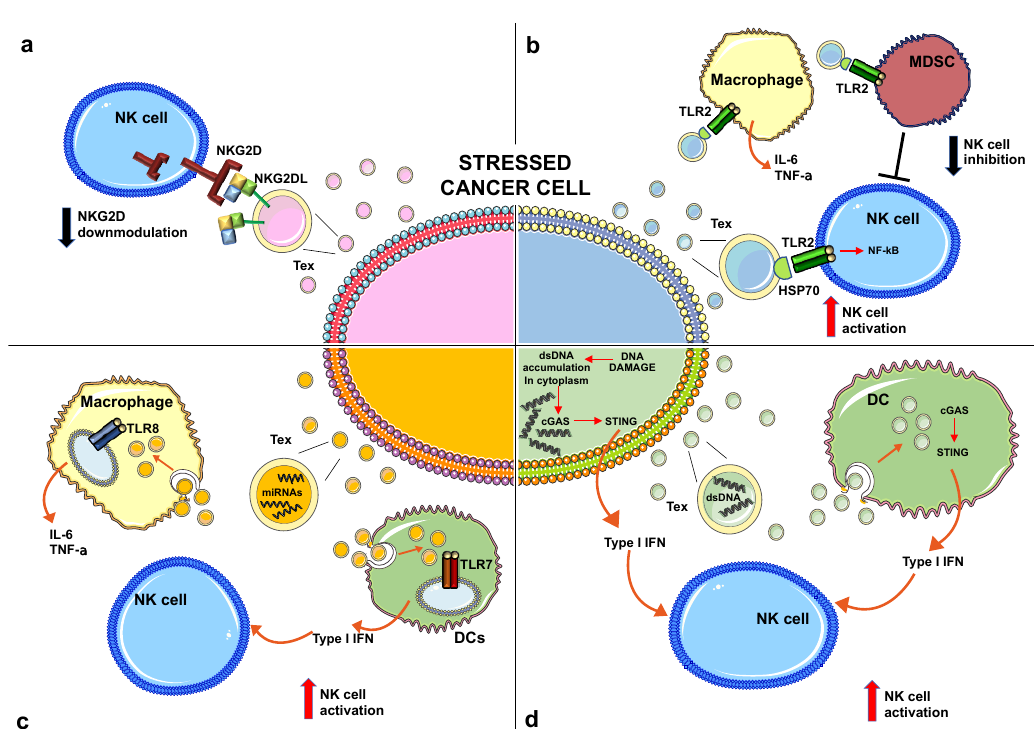
Figure 1. Effects of distinct molecules produced by stressed cancer cells on NK cell-mediated functions. ( a ) Exosomes expressing NKG2D ligands induce NKG2D downmodulation leading to an impairment of NKG2D-mediated cytotoxicity. ( b ) Exosomes expressing HSP70 engage TLR2 expressed on distinct innate immune cell populations as indicated. The direct TLR2 engagement on NK cells induces cellular activation. In contrast, TLR2 triggering on MDCSs induces the production of immunosuppressive factors that can impair NK cell activity. ( c ) Specific miRNAs can engage TLR8 expressed by macrophages leading to inflammatory cytokine production or TLR7 on plasmacytoid DCs leading to type I IFN production, that in turn contribute to NK cell activation. ( d ) Double strand DNA (dsDNA) accumulates in the cytoplasm of cancer cells in response to stress stimuli where it activates the cGAS/STING pathway leading to type I IFN production; in turn, dsDNA is packaged into exosomes and released in the tumor microenvironment where it is taken up by DCs that produce type I IFNs with a mechanism dependent on the cGAS/STING pathway. Type I IFNs, produced either by stressed cancer cells or DCs, activate NK cell-mediated functions, including cytotoxicity and cytokine production. “T” means inhibition. NK, Natural Killer; HSP70, Heat shock protein 70; NKG2D, NK group 2 member D; TLR2, Toll-like receptor 2; MDSCs, Myeloid suppressor cells; IFN, interferon; cGAS, Cyclic guanosine monophosphate (GMP)-adenosine monophosphate synthase; STING, stimulator of IFN gene.